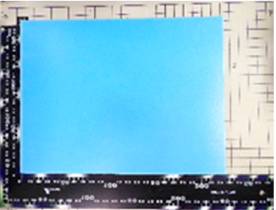
Figure 3. Foamed polypropylene plate before painting.